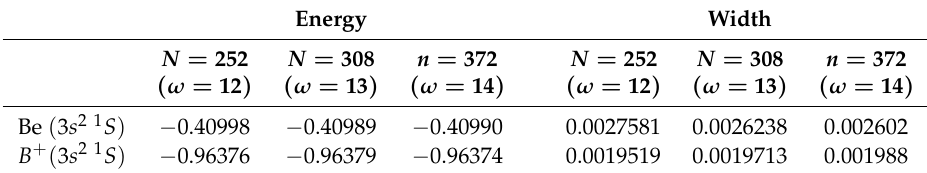
Table 2. Energies (in a.u.) and widths (in a.u.) of the DESs of the Be-like ions for λ = 0 lying above the 1 s 2 2 p threshold for different N in Equation (7). Energies are measured relative to the energy of the corresponding core. Energy Width N = 252 N = 308 n = 372 N = 252 N = 308 n = 372 ( ω = 12 ) ( ω = 13 ) ( ω = 14 ) ( ω = 12 ) ( ω = 13 ) ( ω = 14 ) Be ( 3 s 2 1 S ) − 0.40998 − 0.40989 − 0.40990 0.0027581 0.0026238 0.002602 B + ( 3 s 2 1 S ) − 0.96376 − 0.96379 − 0.96374 0.0019519 0.0019713 0.001988